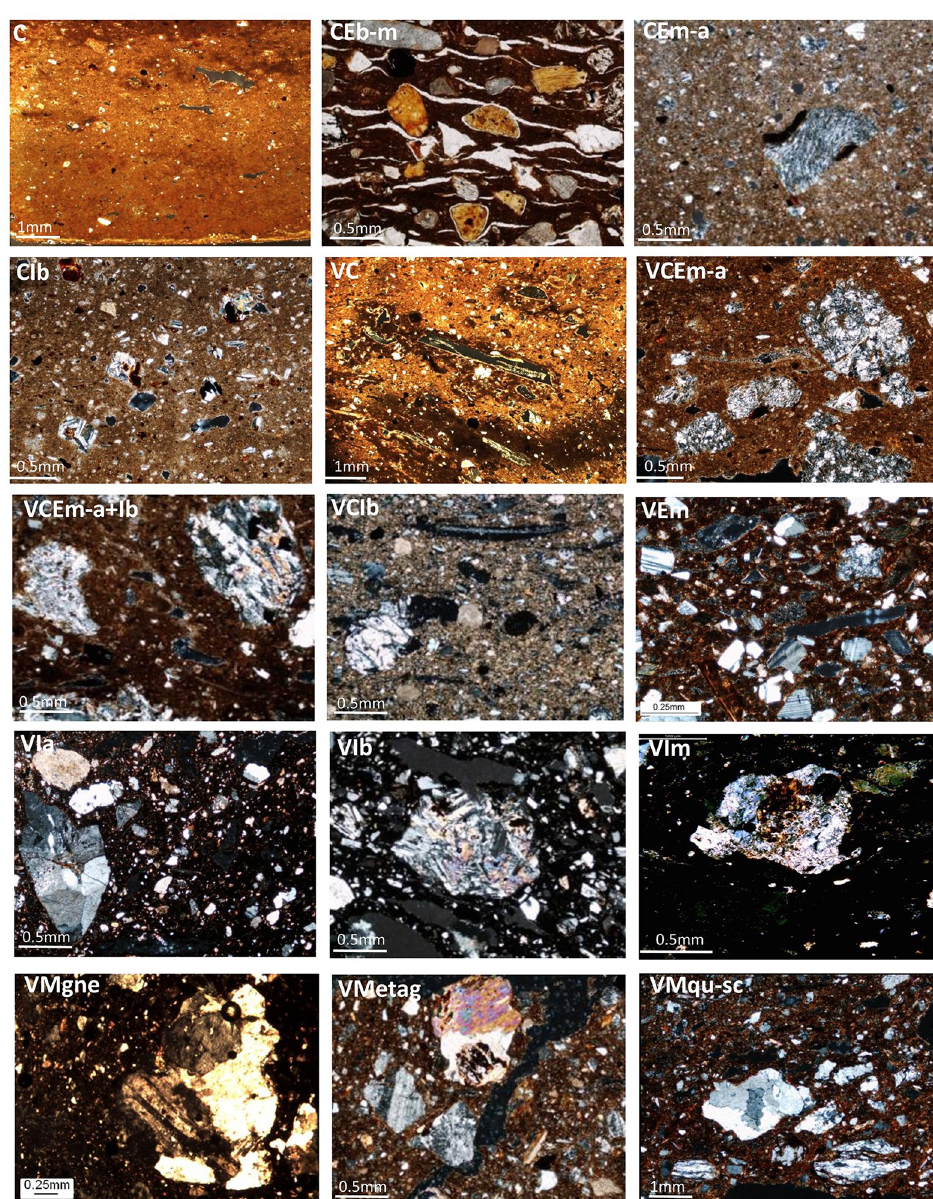
Fig 6. Selected micro-pictures illustrating the main petro-groups. Image: O¨AW-O¨AI / P. Fragnoli.